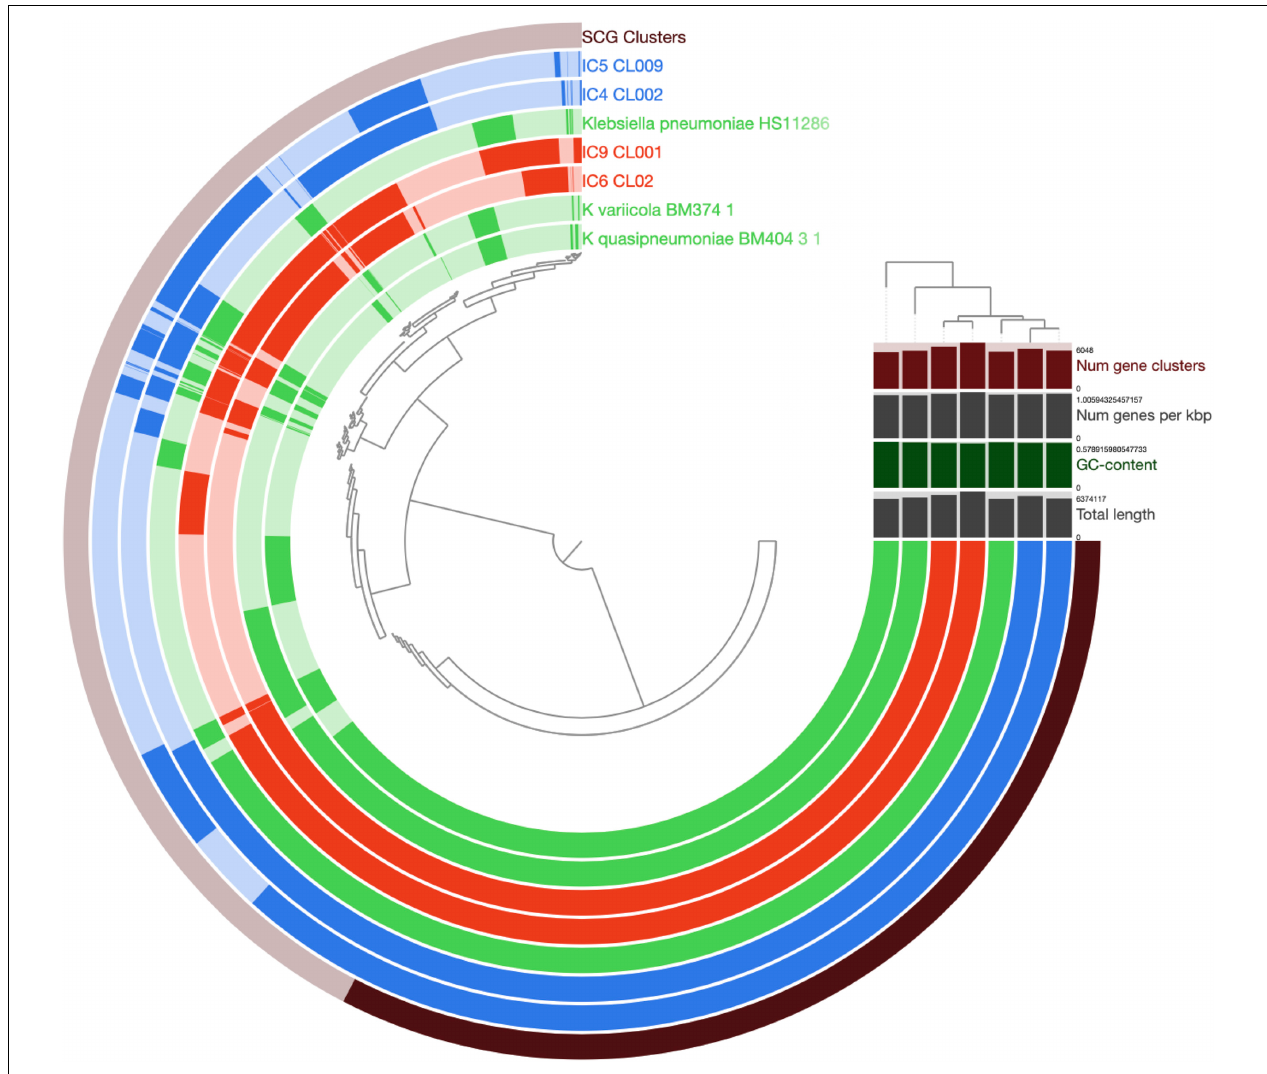
FIGURE 4 | Comparison of K. pneumoniae MAGs across the patients and time points. The genomes of K. pneumoniae strain HS11286, K. variicola BM374-1 and K. quasipneumoniae BM404-3-1 were included as external references. The circular hierarchical clustering diagram was constructed using the anvi’o pipeline (see section “Materials and Methods”). Each concentric circle represents a genome, while each radial ray corresponds to a gene (gene orthology cluster). The outermost circle shows the SCG genes (in black). The genomes/circles were hierarchically clustered based on their SCG sequence similarity, while the genes – on their prevalence pattern across the genomes. For the circles, the Kp MAGs of patient A and B are shown in blue and red, respectively; the reference genomes – in green. Saturated colors correspond to present genes, while pale ones – to the absent ones. In the upper right part, the total number of gene clusters, the gene density (number of genes per Kbp of genome), GC content (%) and total length are provided for each